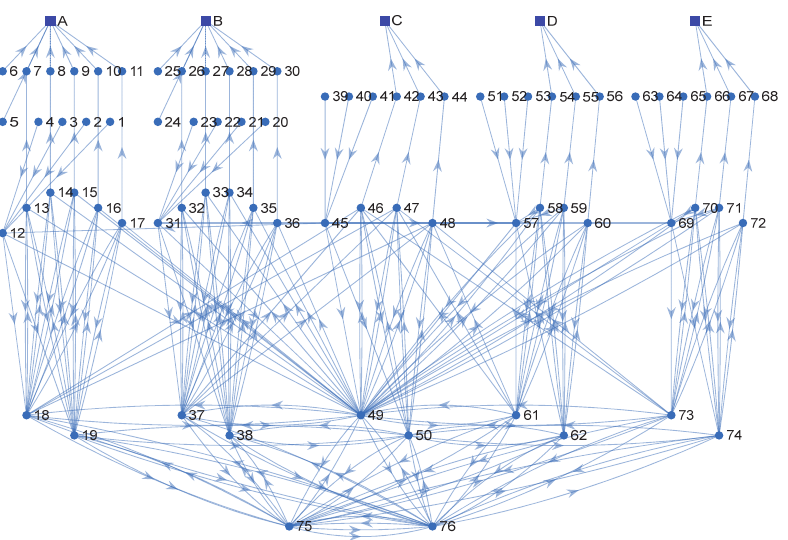
Figure 5. TVPHAG of D2-1 smart substation.